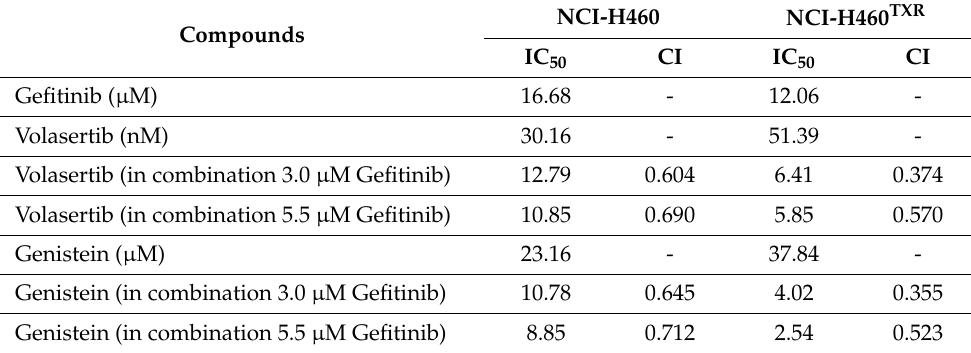
Table 1. The half maximal inhibitory concentration (IC 50 ) values of gefitinib, volasertib, and genistein and the combination index (CI) values in NCI-H460 and NCI-H460 TXR cells.